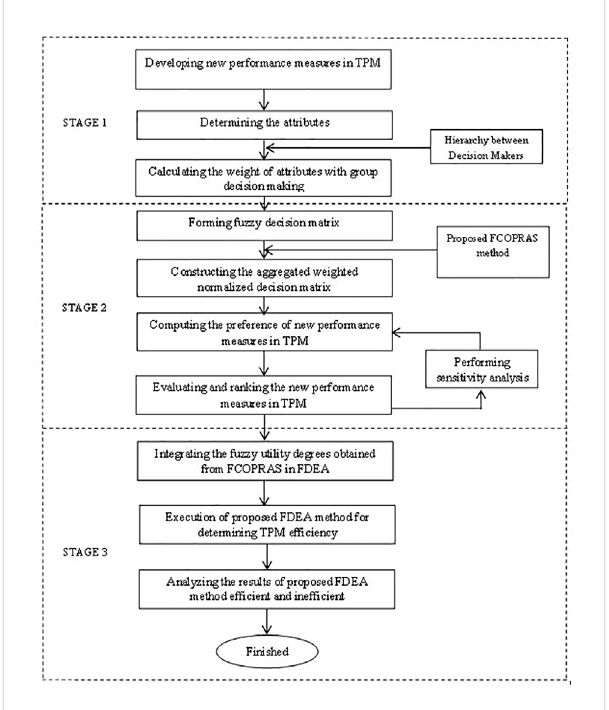
FIGURE 2 The fl ow diagram of the integrated FCOPRAS-FDEA